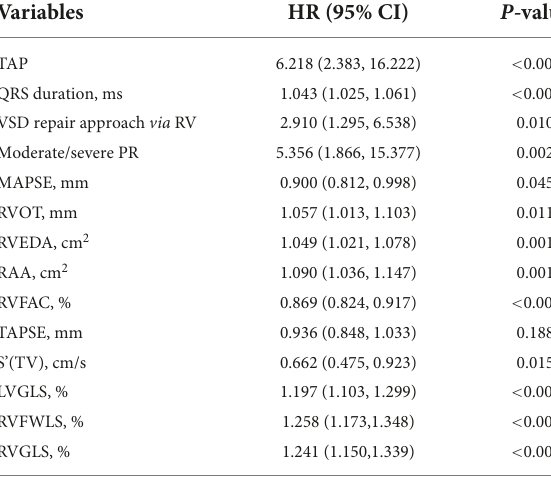
TABLE 3 Predictors of adverse event in patients with r-TOF by univariate cox regression analysis.